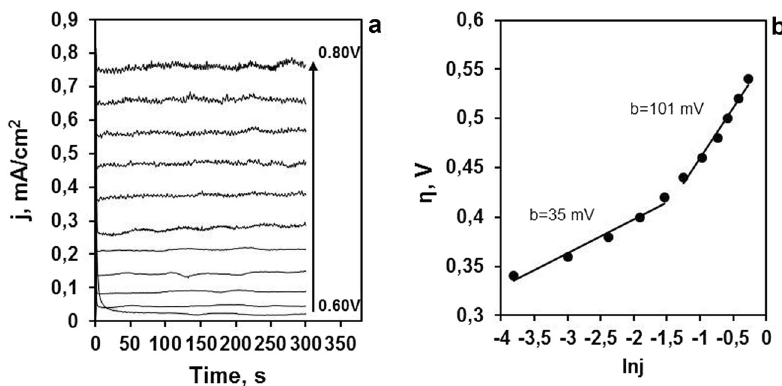
Fig. 6 Characteristic voltamperograms ( a ) and Tafel plot ( b ) for Co 3 O 4 films deposited from cobalt nitrate. 0.1 M NaOH supporting